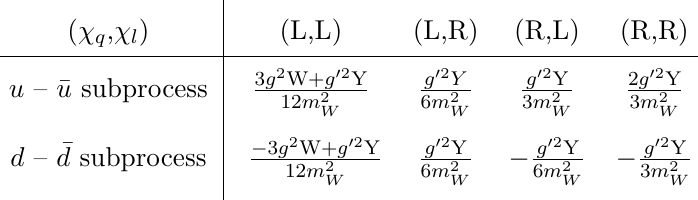
Table 7 . Explicit expressions for the new physics coefficients K 0 O 0 and O 0 operators. 2 W 2 B